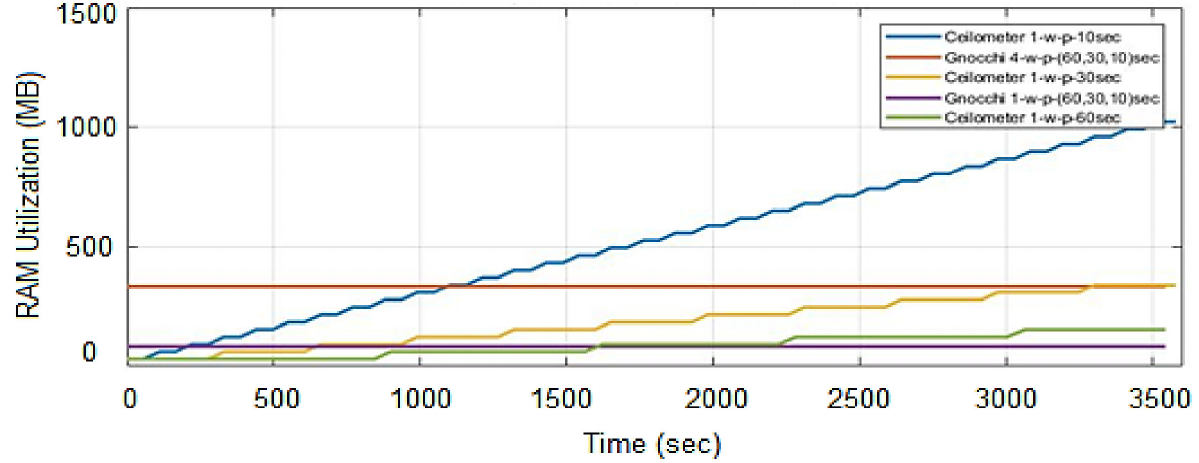
Figure 14. Memory usage comparison of Ceilometer and